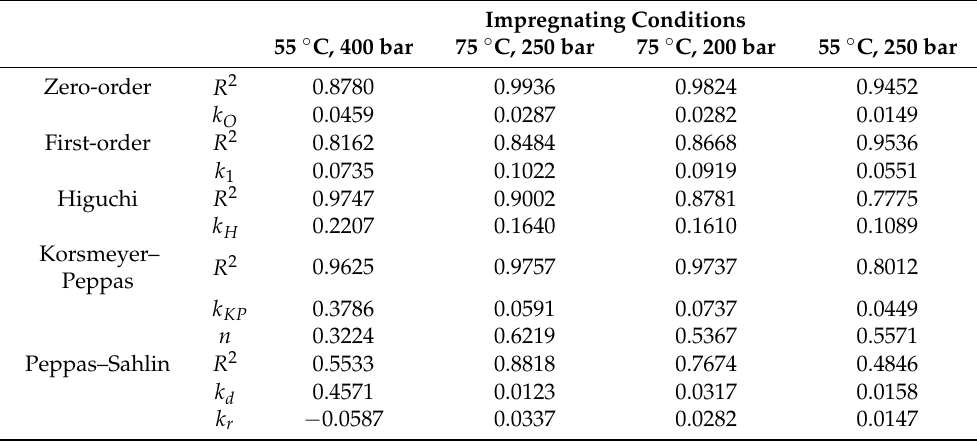
Figure 8. Release profiles of the different ketoprofen-impregnated PLA filament samples fit to different mathematical models. Table 6. Model parameters and R-squared values obtained from the fitting of the ketoprofen-impregnated PLA filament samples to the different mathematical models.